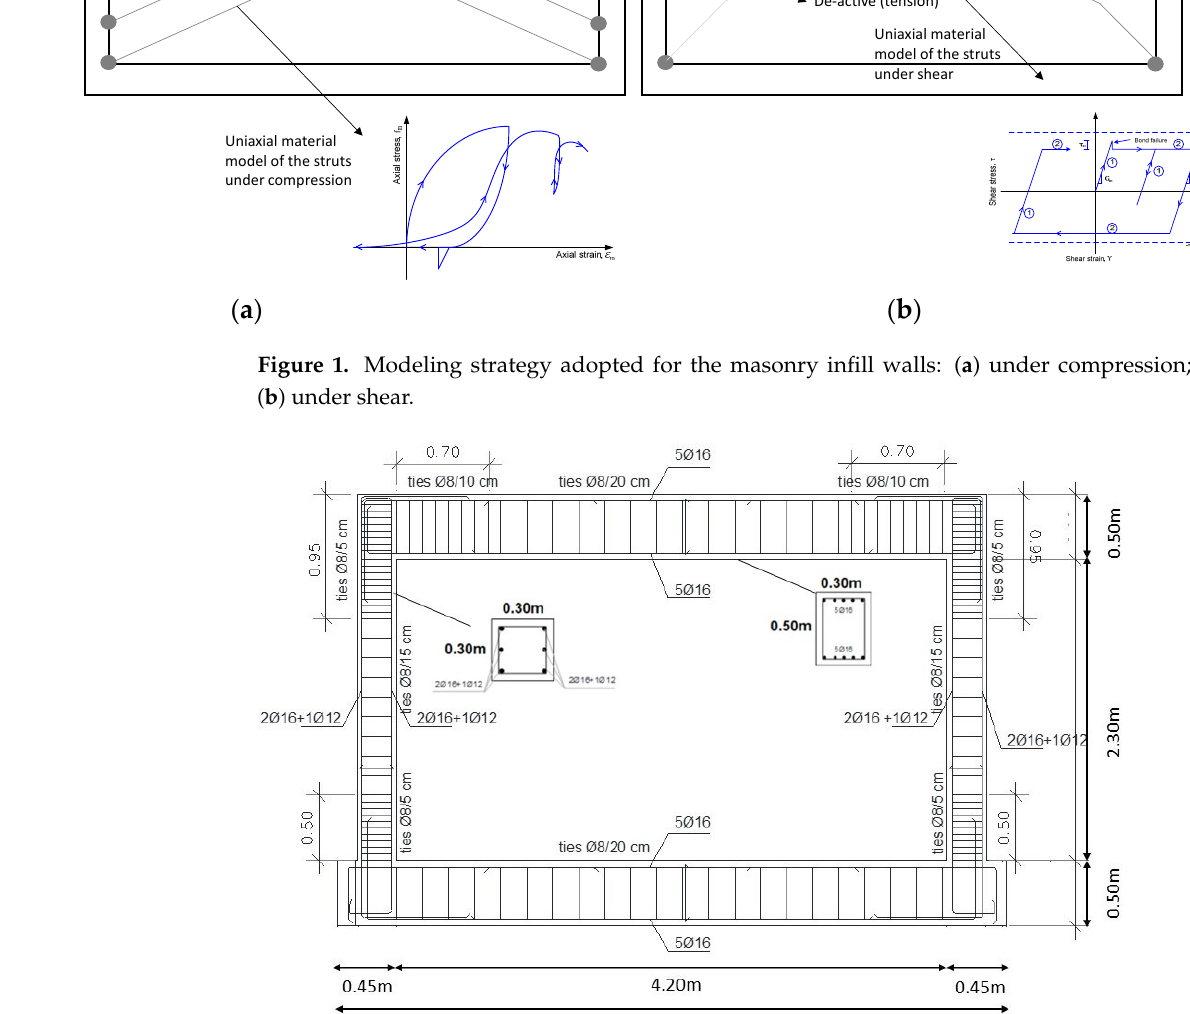
Figure 2. RC frame geometry and reinforcement